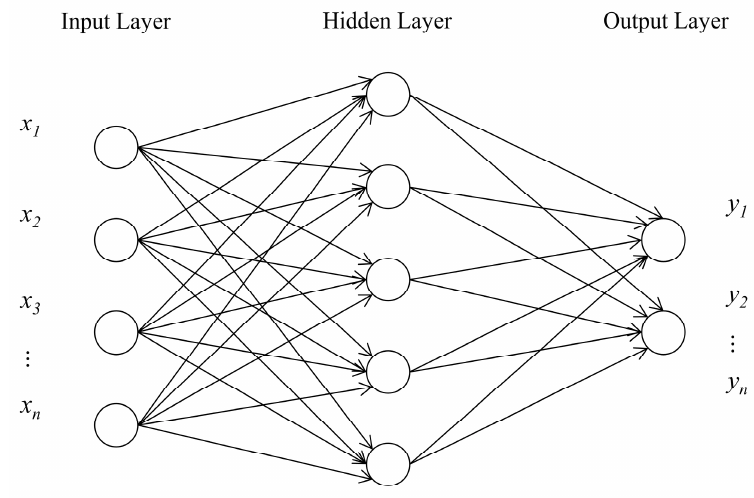
Figure 3. Architecture of the BP neural network.